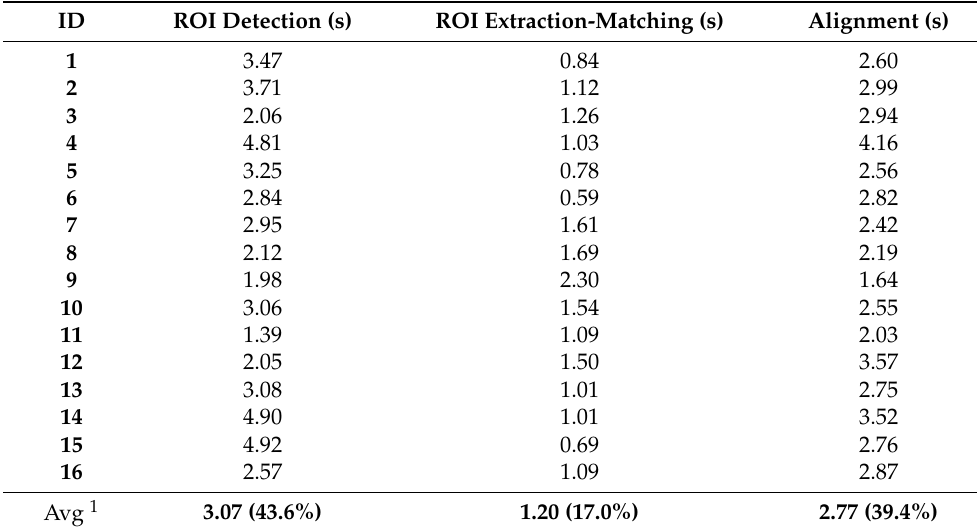
Table 4. Computation time for each planar-equirectangular image stitching pipeline steps (in seconds). The majority of the computation times were occurred on the ROI detection step ( 43.6%), followed by alignment ( 39.4%) and ROI feature extraction-matching ( 17.0%), respectively. ID ROI Detection (s) ROI Extraction-Matching (s) Alignment (s) 1 3.47